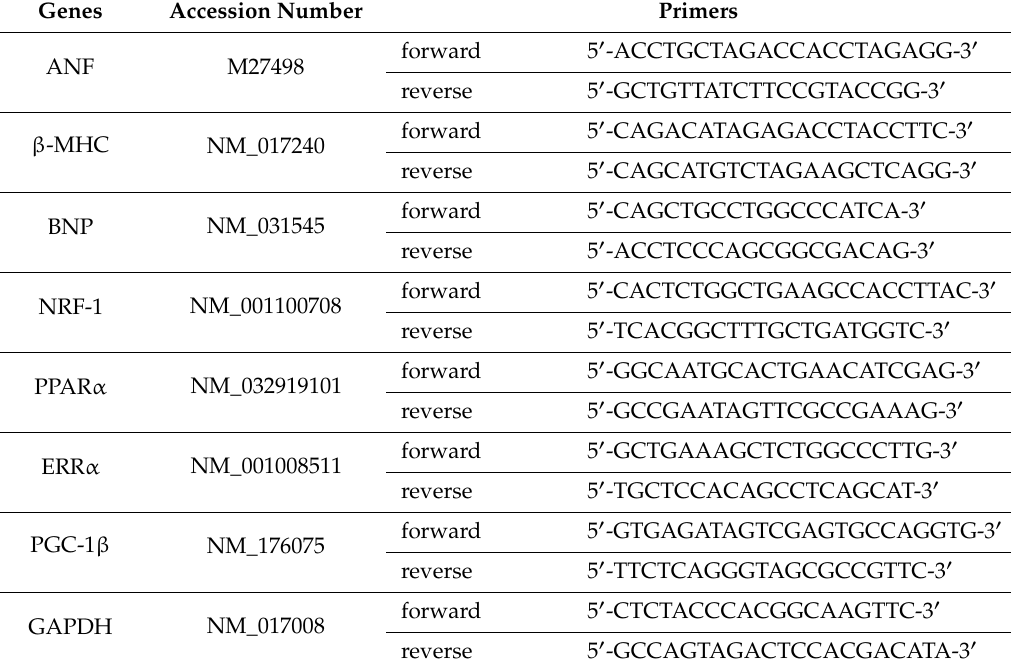
Table 1. Specific primer sequences Quantitative Real-Time Polymerase Chain Reaction